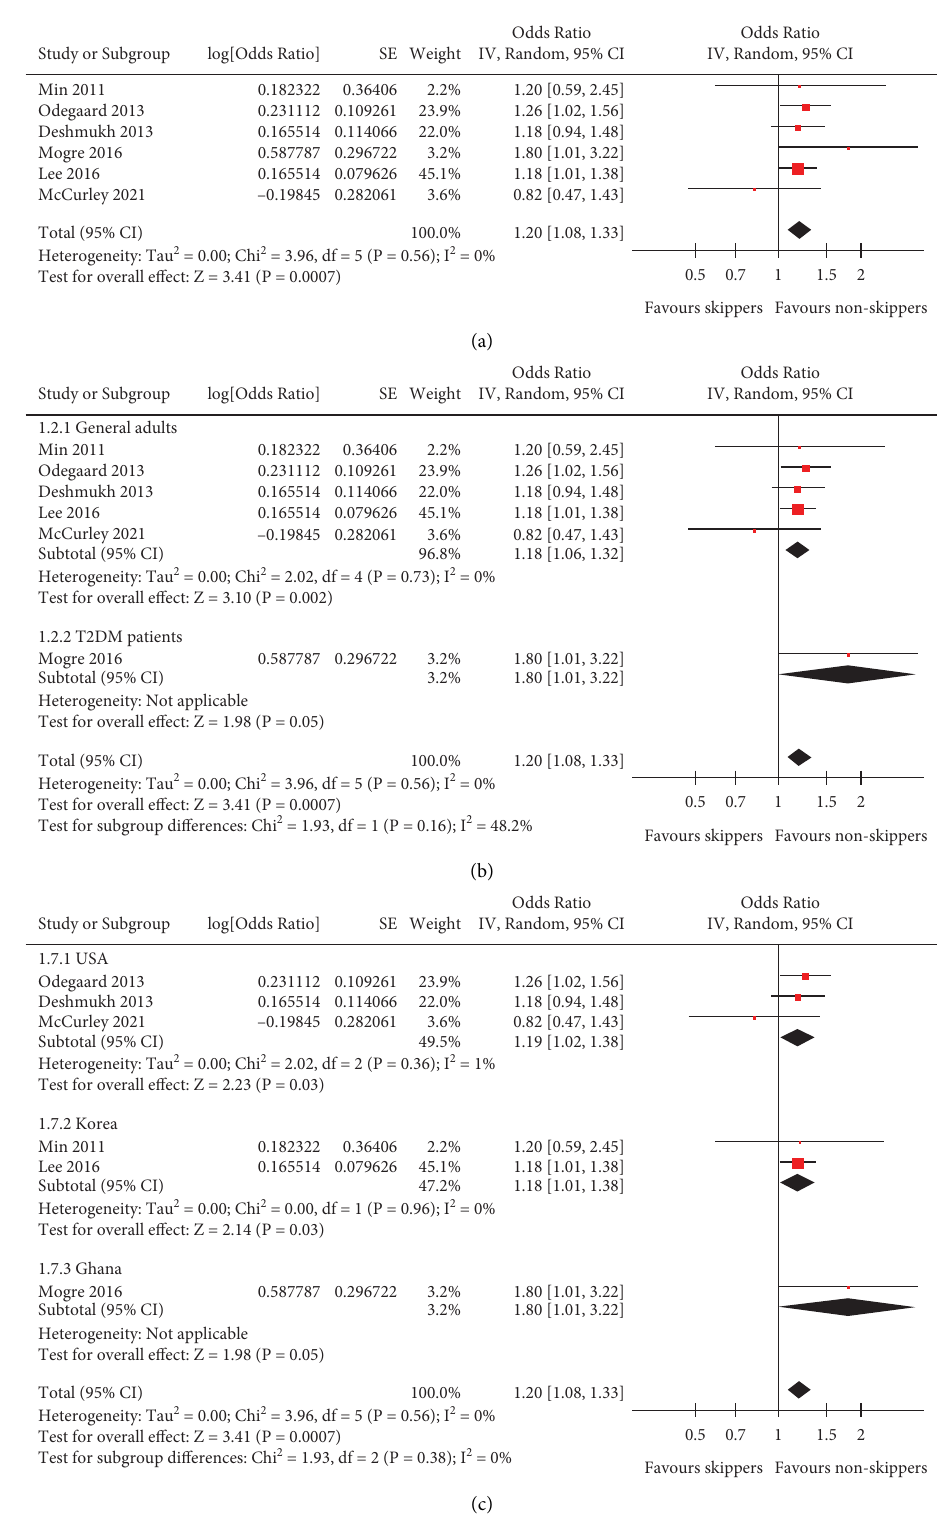
Figure 2: Forest plots for the meta-analysis of the association between skipping breakfast and hypertension in the adult population. (a) Results of overall meta-analysis. (b) Subgroup analysis according to the characteristics of the included participants. (c) Subgroup analysis according to the country of the